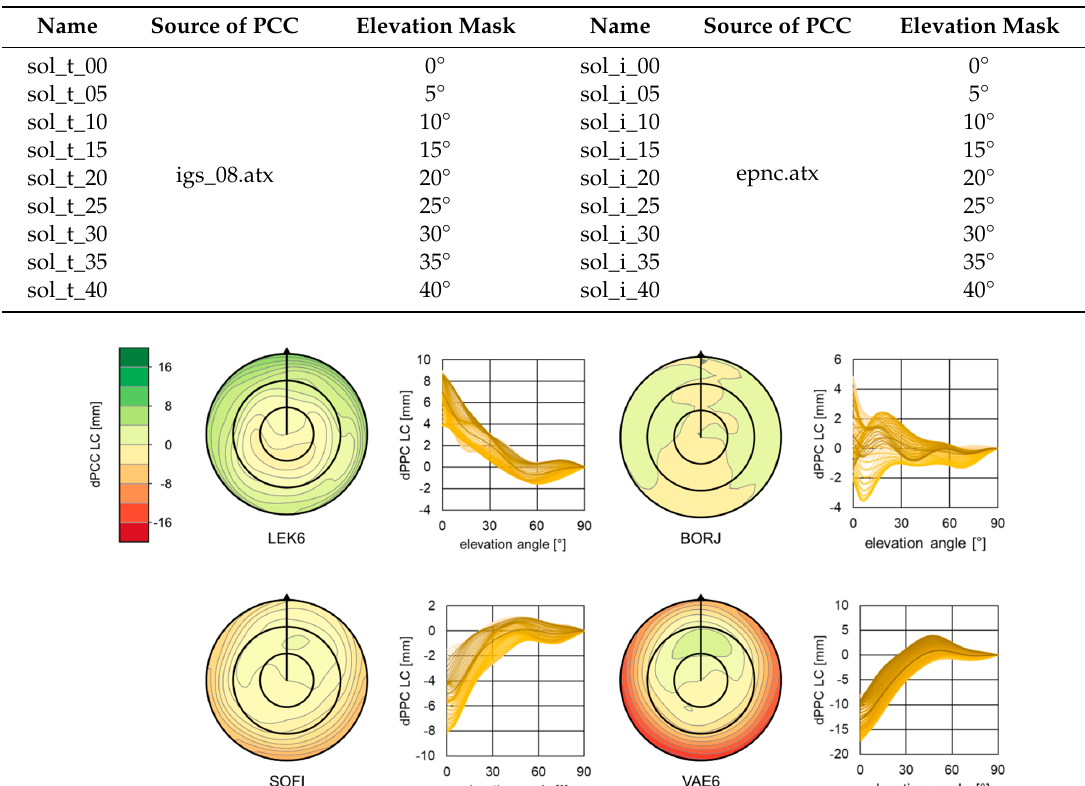
Figure 2. Differences in the phase center corrections (PCCs) for “ionosphere-free” linear combination for the LEIAR25.R3 LEIT antenna at selected EUREF permanent global navigation satellite system (GNSS) network (EPN) stations.